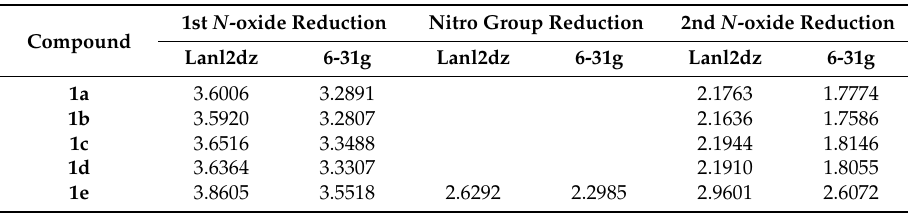
Table 4. The half-cell reaction potentials in volts for the 1st N -oxide, nitro group and 2nd N -oxide reductions calculated using the lanl2dz and 6-31g basis sets in Gausian 09. Compound 1st N -oxide Reduction Nitro Group